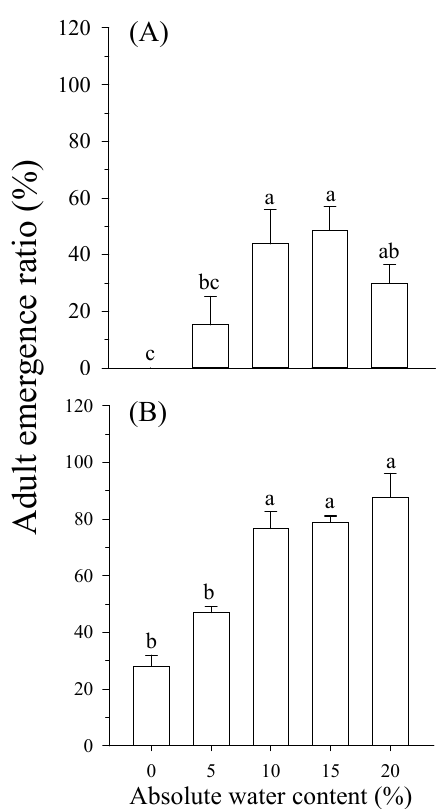
Figure 4. Adult emergence of pupae immersed in soil at different moisture levels. ( A ): Adult emergence from pupae immersed at the early stage. ( B ): Adult emergence from pupae immersed at the late stage. Means (±SE) among different soil moistures followed by different letters differ at p < 0.05 (Tukey HSD test).